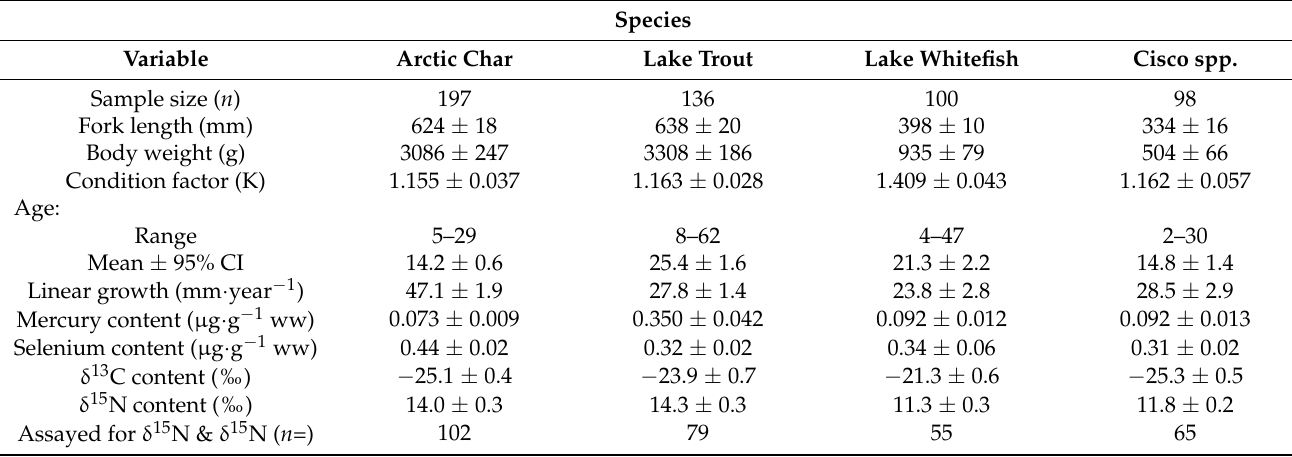
Table 2. Sample size, morphometric data, and age, as well as mercury, selenium, and stable isotope ratios obtained from muscle samples derived from four salmonid species caught in the Kitikmeot region of Nunavut, Canada, with the number of fish sampled shown as n (except for the stable isotope analysis, which is adjacently noted), and with units indicated in parentheses and calculations shown as means and 95% confidence intervals (CI).